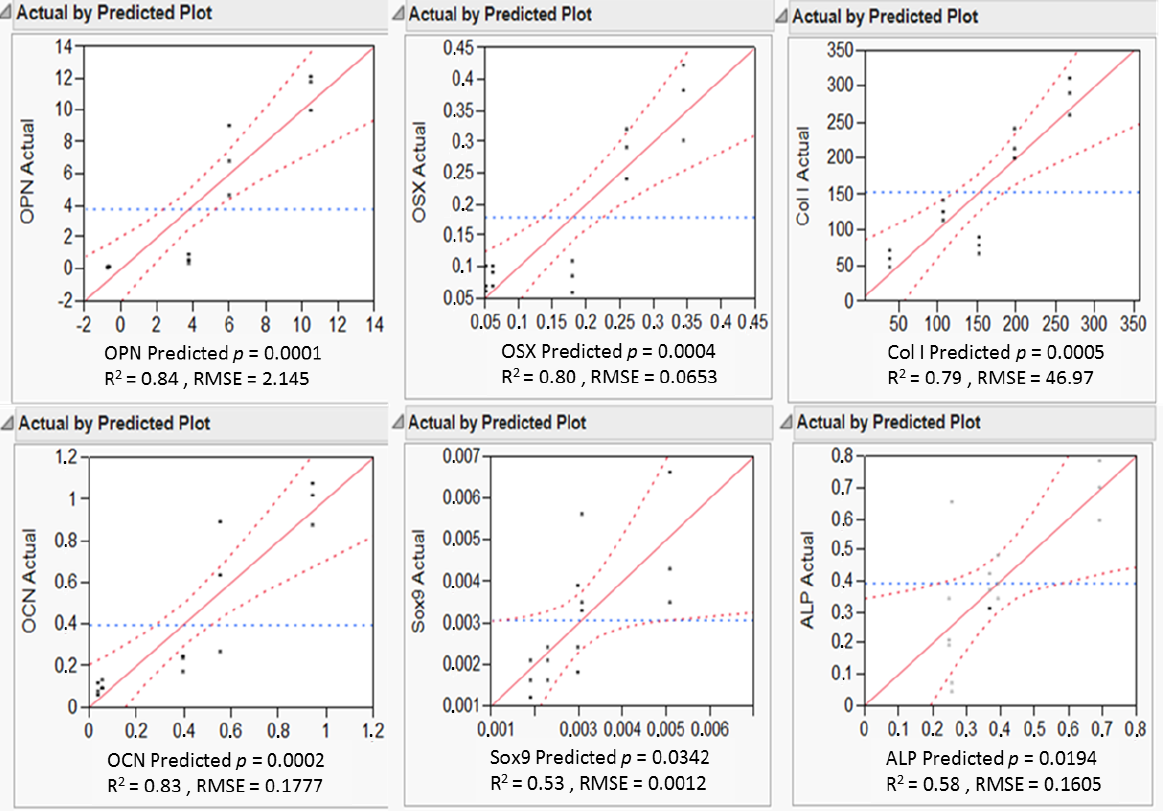
Figure 6. Goodness-of-fit between predicted values obtained via partial least-squares fitting and experimentally measured gene expression values, for the selected genes studied in this study. R 2 values are also given for all